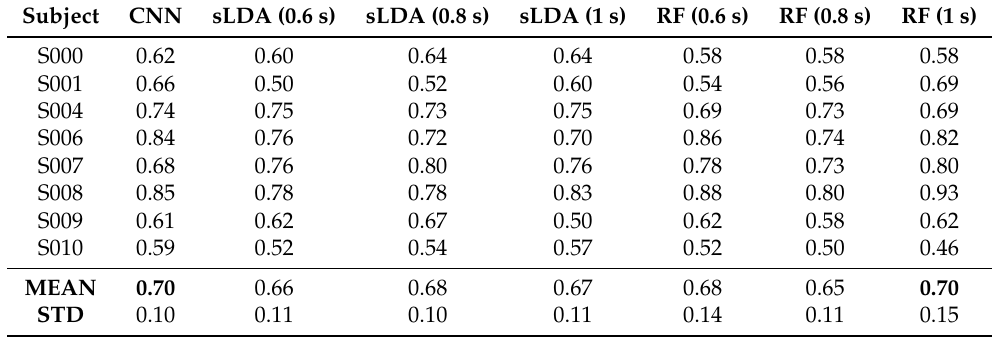
Table 1. Comparison of classification performance (in terms of accuracy) in validation from Dataset 1 .